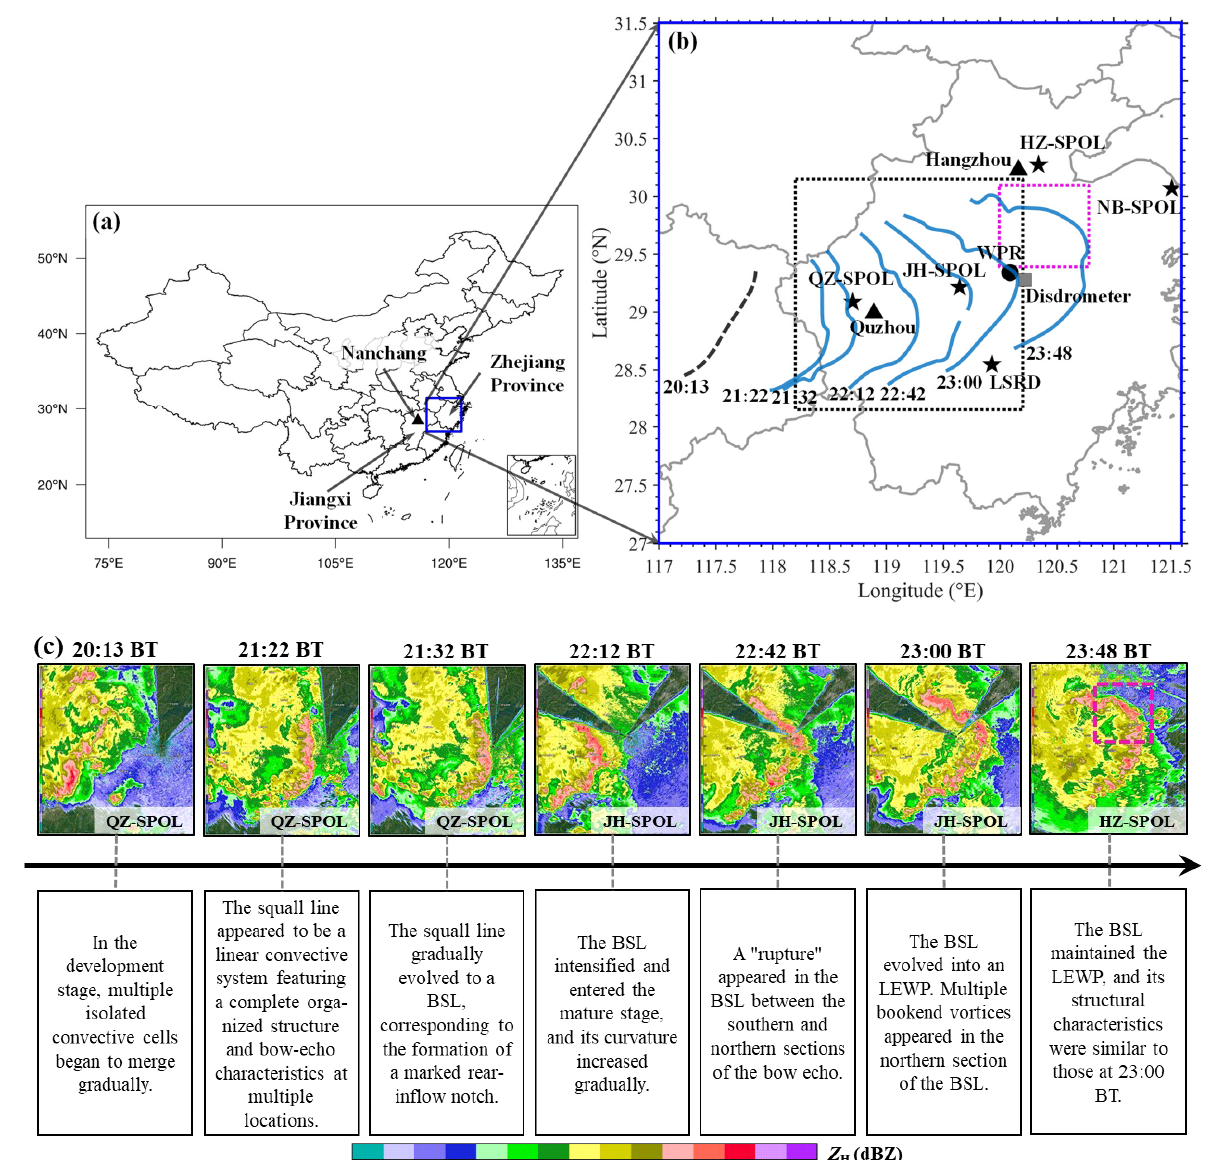
Figure 1. ( a ) Map of China showing the domain for this study. The blue box and black triangle indicate the boundaries of the study area and the location of the Nanchang sounding station, respectively. ( b ) Locations of the observational instruments and stations. The black five-pointed stars indicate the locations of QZ-SPOL, JH-SPOL, HZ-SPOL, NB-SPOL, and LSRD. The JH-SPOL is 92 and 79 km from the QZ-SPOL and LSRD, respectively. The NB-SPOL is 114 km from the HZ-SPOL. The gray square represents the location of the disdrometer at Dongyang station, the black circle indicates the location of the WPR in Yiwu, and the black triangles denote the locations of sounding stations in Hangzhou and Quzhou (the Quzhou AWS is in the same location). The dashed black line represents the leading edge location of the squall line during the formative stage (2013 BT), and the solid blue lines mark the leading edge locations of the BSL of interest at different times during the mature stage (2122, 2132, 2212, 2242, 2300, and 2348 BT). The black and magenta dotted boxes indicate the boundaries of the retrieved 3D wind fields of QZ-SPOL, JH-SPOL, and LSRD and HZ-SPOL and NB-SPOL, respectively. ( c ) The visual timeline of radar echo patterns (scan at a 0.5° elevation angle for QZ-SPOL and JH-SPOL and a 1.5° elevation angle for HZ-SPOL) in different stages labeled with short descriptions of the evolution characteristic of the squall line.